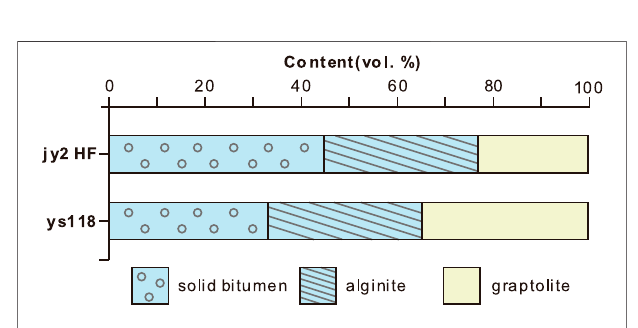
FIGURE 4 | The distribution of macerals in shale